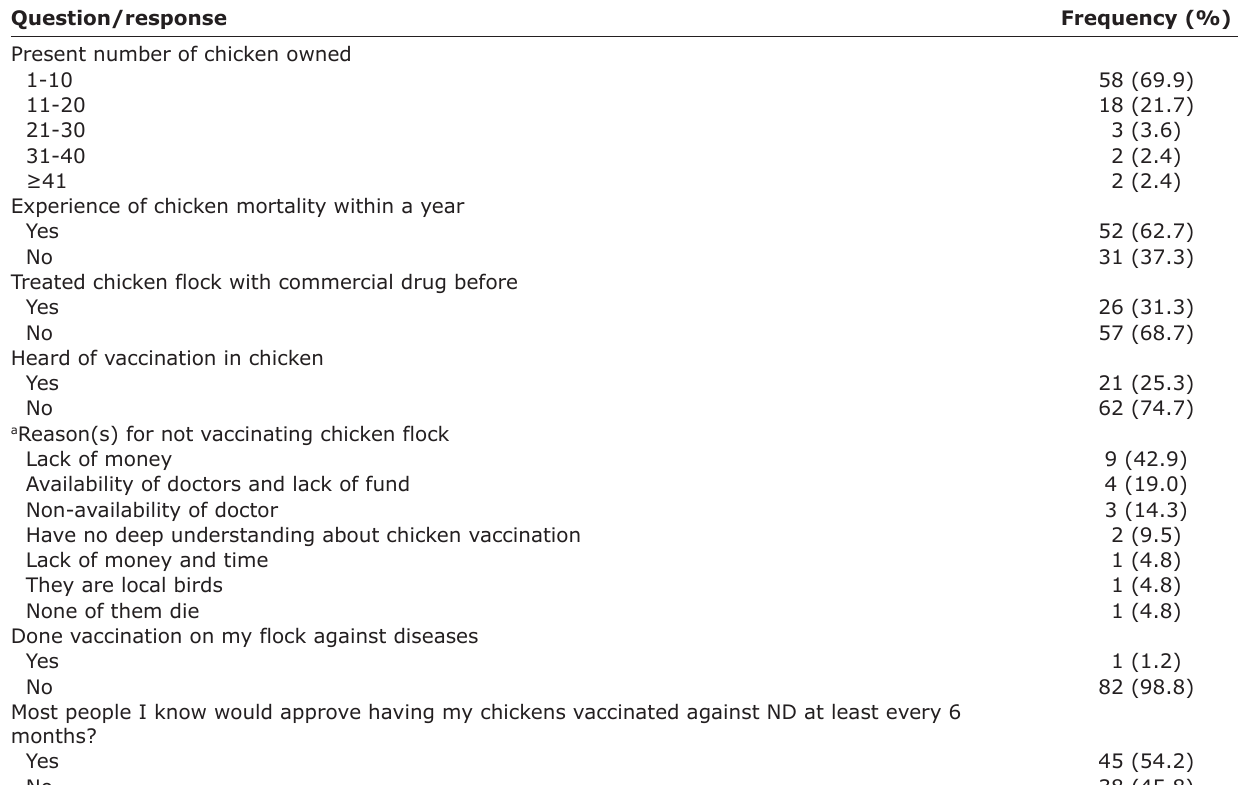
Table-1: Awareness on village poultry vaccination and experience of keepers on ND.